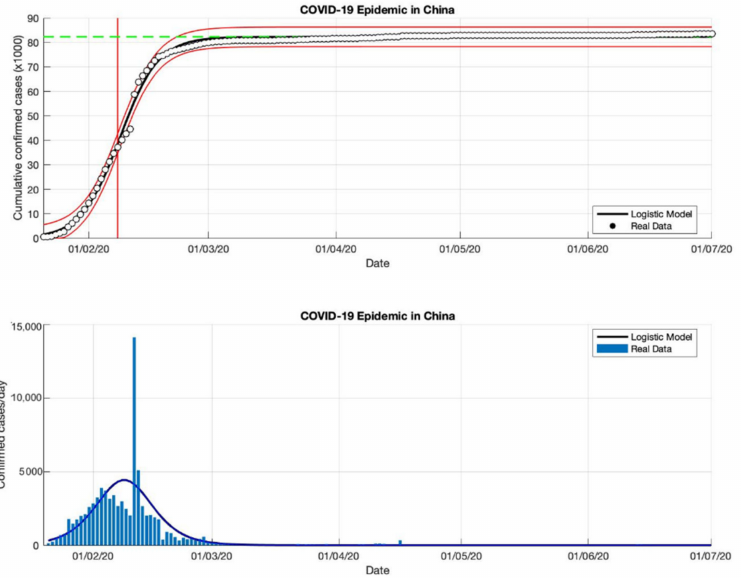
Figure 3. In the above figure, the prediction results of the logistic growth model for cumulative infected cases are compared with the actual data, while the two red lines between the black lines represent a prediction error limit of about 5%. The dashed green line predicts the total size of infected cases in the final phase of the epidemic. The red line intersects the cumulative case curve to predict the turning point or peak point of the epidemic (this line is parallel to the top of the curve from the below figure). In the below figure, the prediction results of this model for daily infected cases